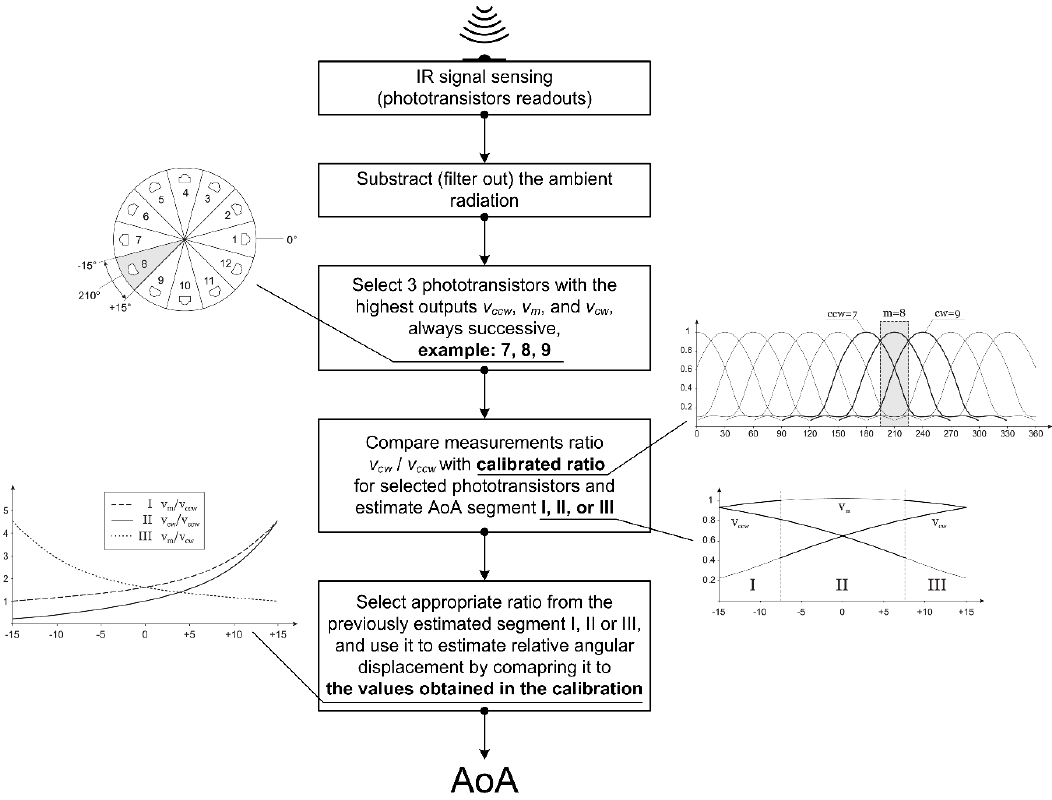
Figure 5. The flowchart of the proposed AoA estimation algorithm.